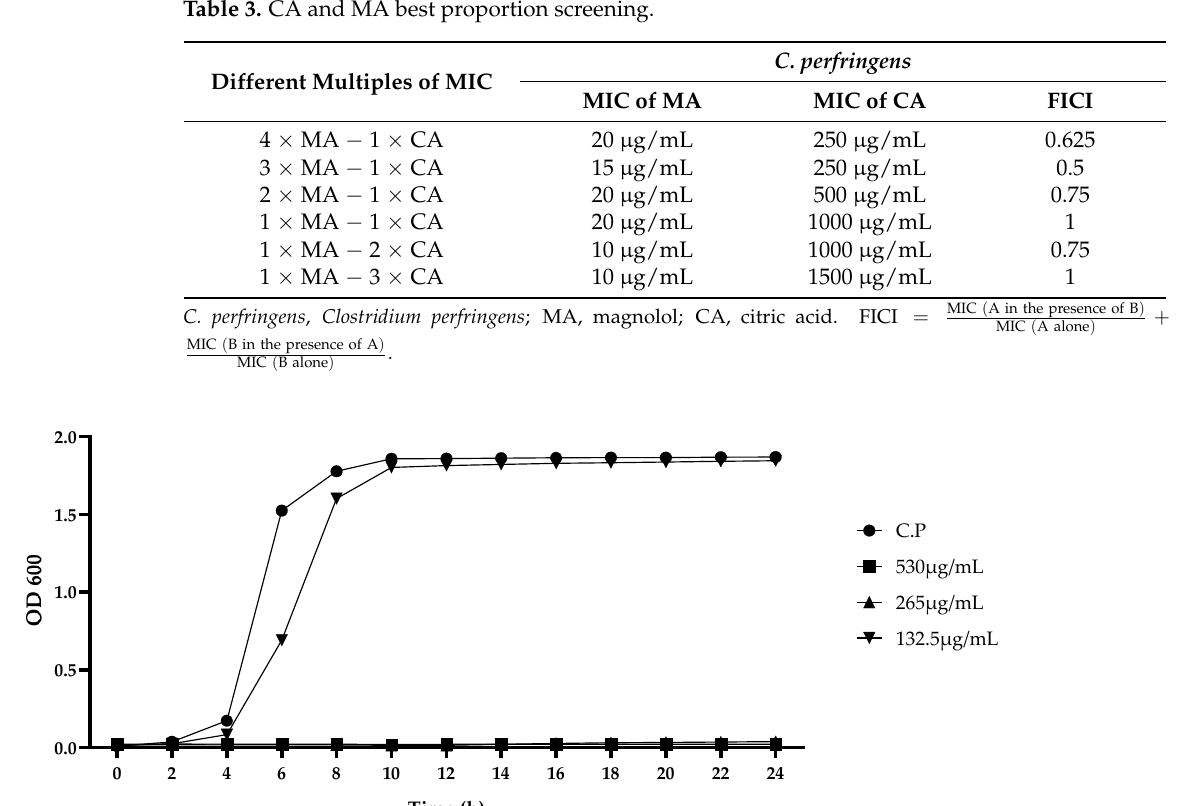
Table 3. CA and MA best proportion screening.